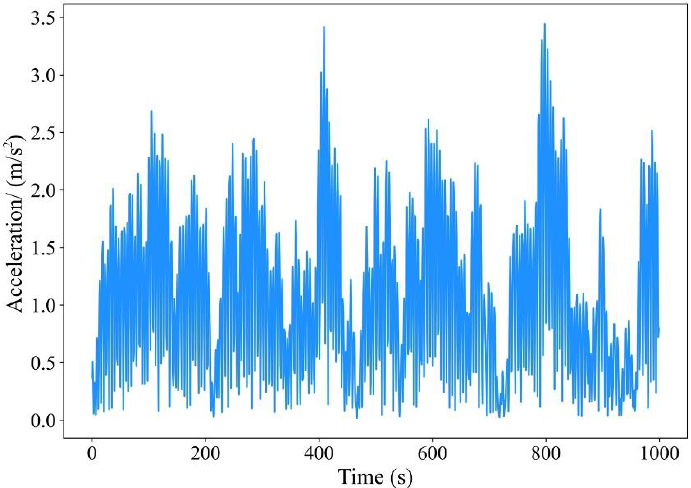
Figure 6. Part of the signal from the first measuring point under 30% damage of the fifth segment in the touchdown zone. the touchdown